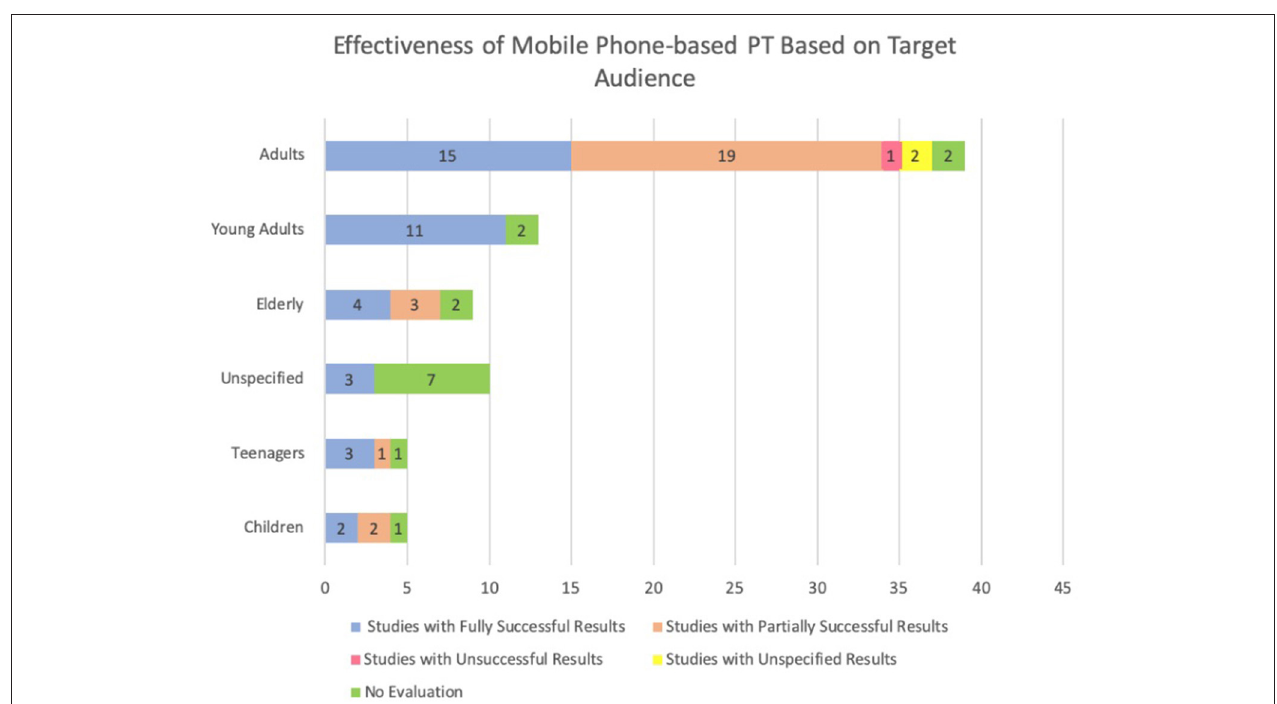
FIGURE 16 | Effectiveness of mobile phone-based persuasive technology (PT) based on target audience.